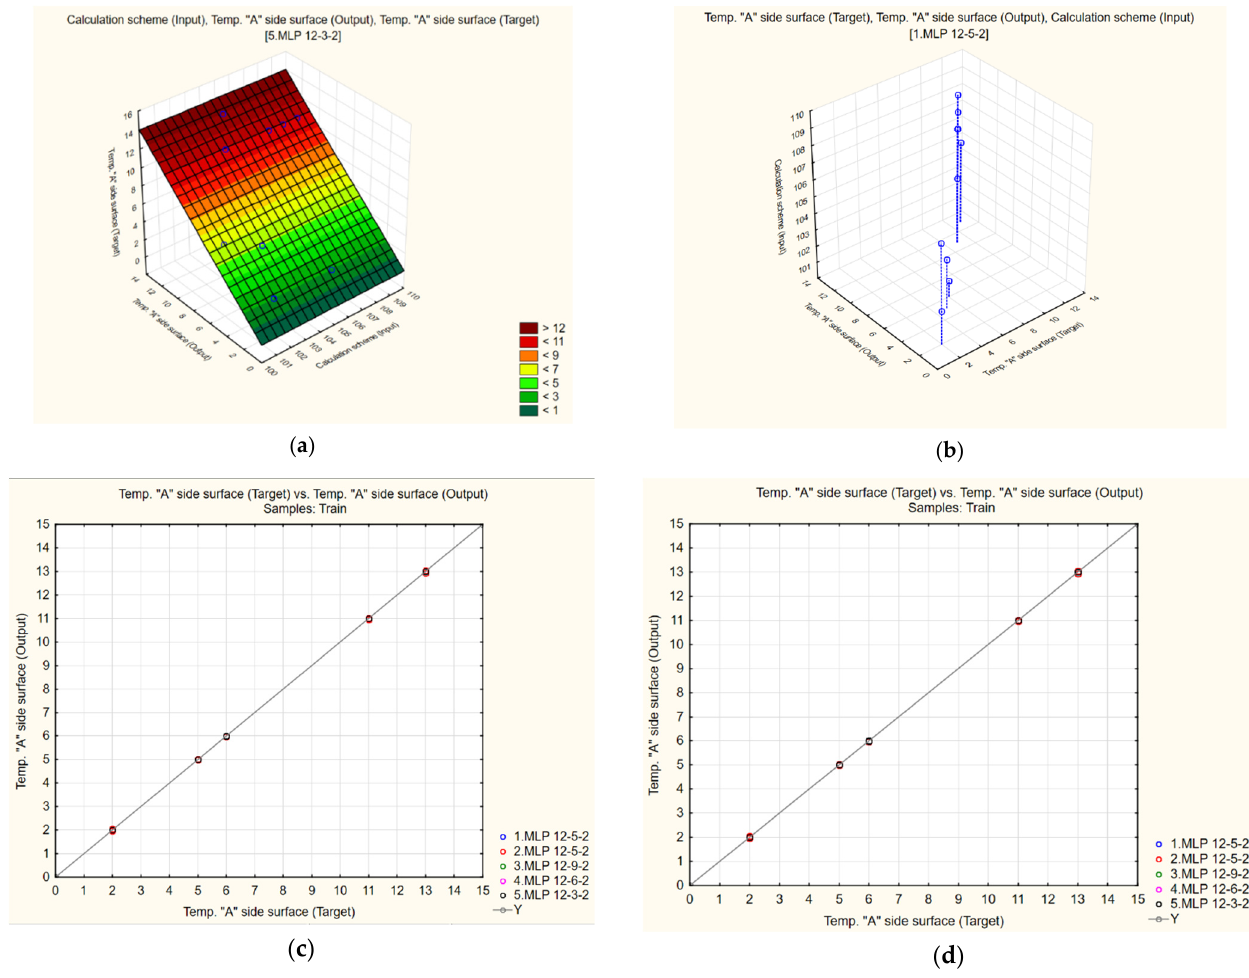
Figure 12. Graphical presentation of the network results ( a ) scheme of temp. A according to predicted value, ( b ) scheme of temp. A according to predicted value and calculation scheme, ( c , d ) scheme of temp. A according to predicted value for five different spreadsheets.